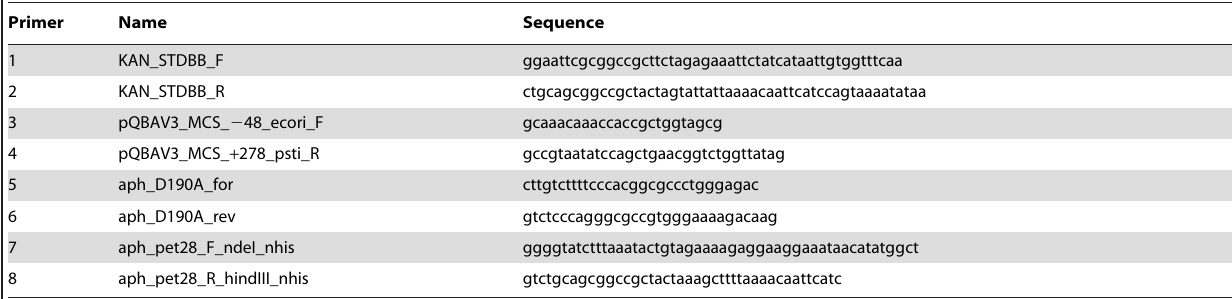
Table 1. Primers used in this